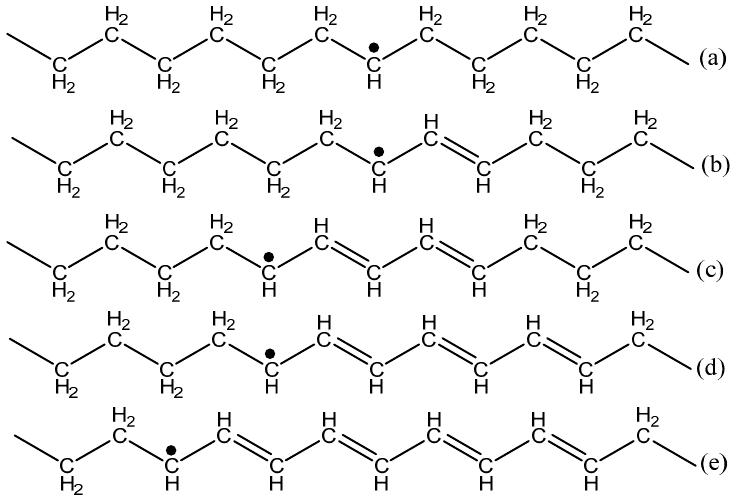
Figure 1. Free radicals expected from the irradiation of polyethylene. Schematic drawing of the (a) alkyl, (b) allyl, (c) dienyl, (d) trienyl, and (e) tetraenyl free radicals.